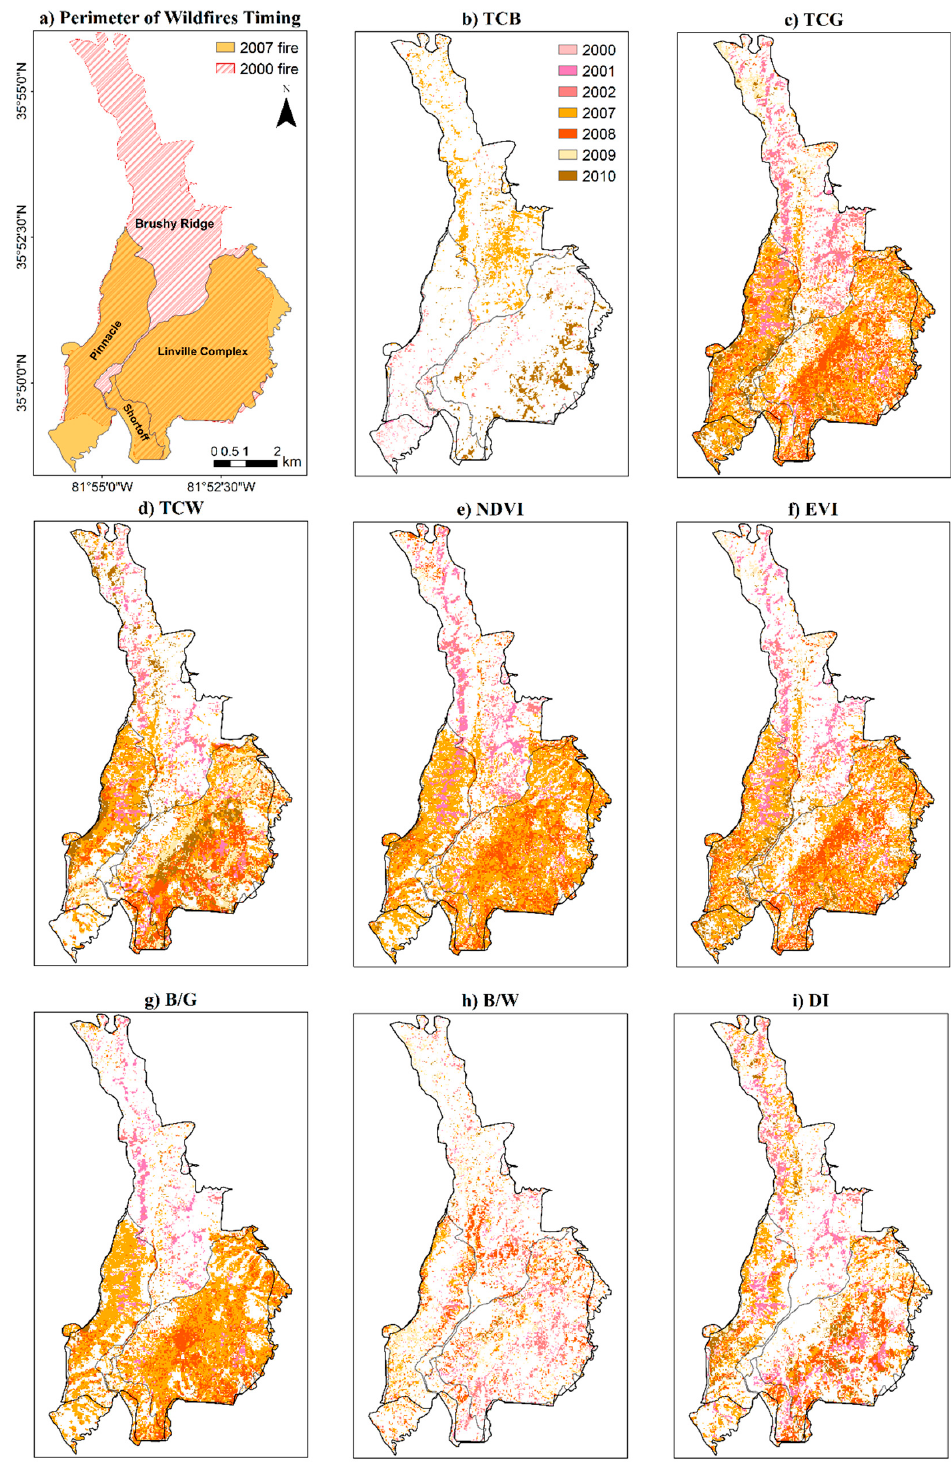
Figure 7. Spatial distributions of ( a ) 2000 and 2007 fire perimeters by the Wildland Fire Decision Support System (WFDSS) fire history map, and the maximum disturbance timing maps derived from eight spectral indices within sub-region 2 (Figure 1): ( b ) brightness (TCB), ( c ) greenness (TCG), ( d ) TCW, ( e ) NDVI, ( f ) Enhanced Vegetation Index (EVI), ( g ) TCB/TCG (B/G), ( h ) TCB/TCW (B/W), and ( i ) Disturbance Index (DI) (Table 1). The legend in map (b) applies to all the maps.